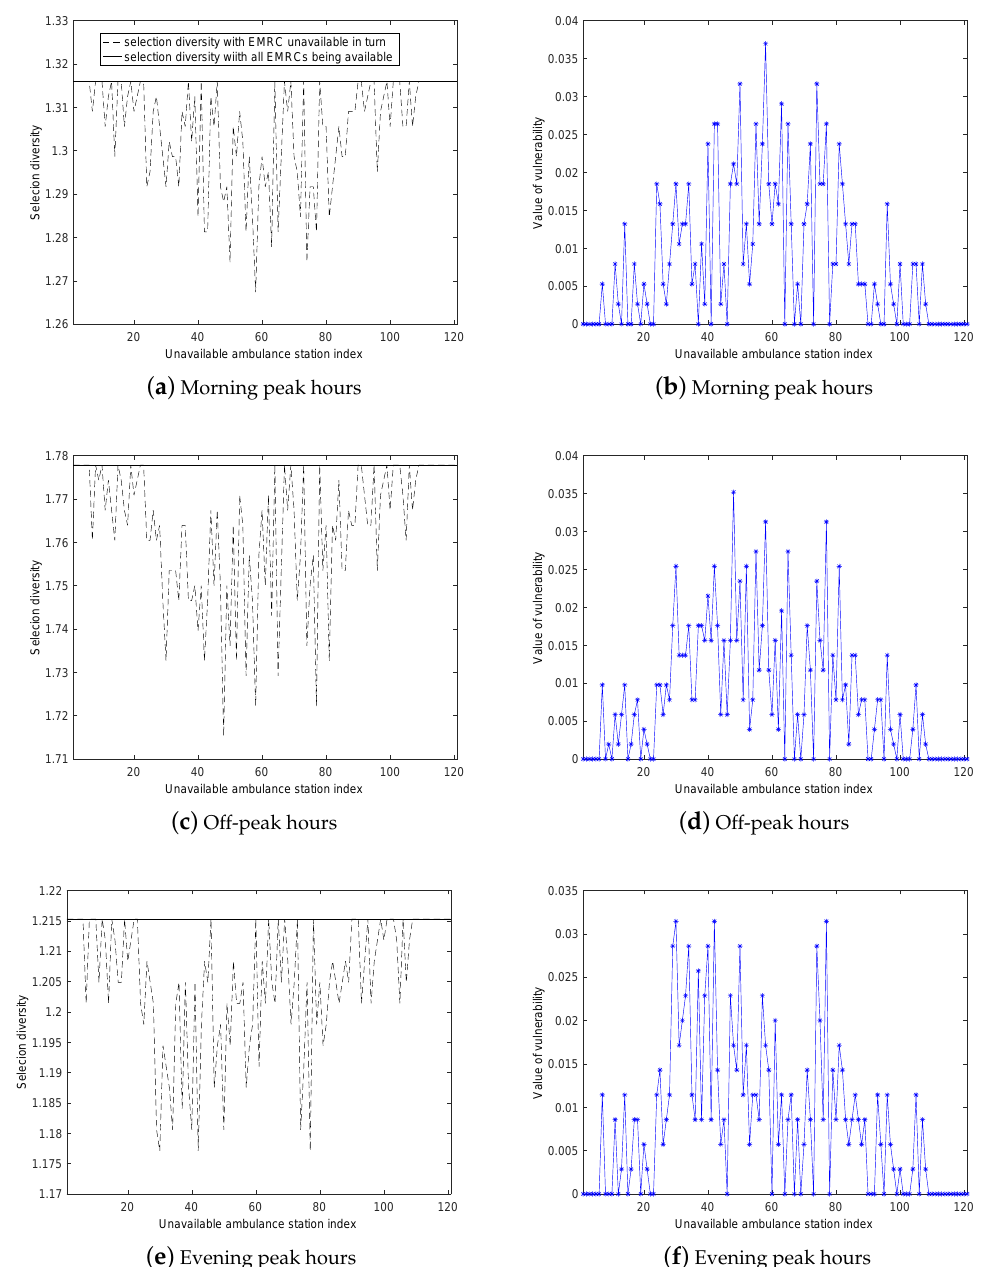
Figure 7. Vulnerability analysis with ambulance station unavailable in